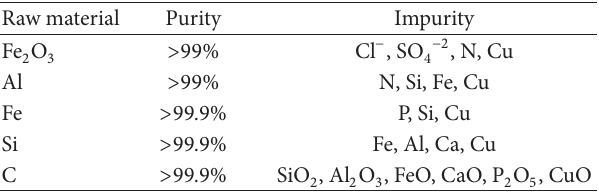
Table 1: The composition of the raw powder (wt.%). Table 2: Chemical composition of the raw powders